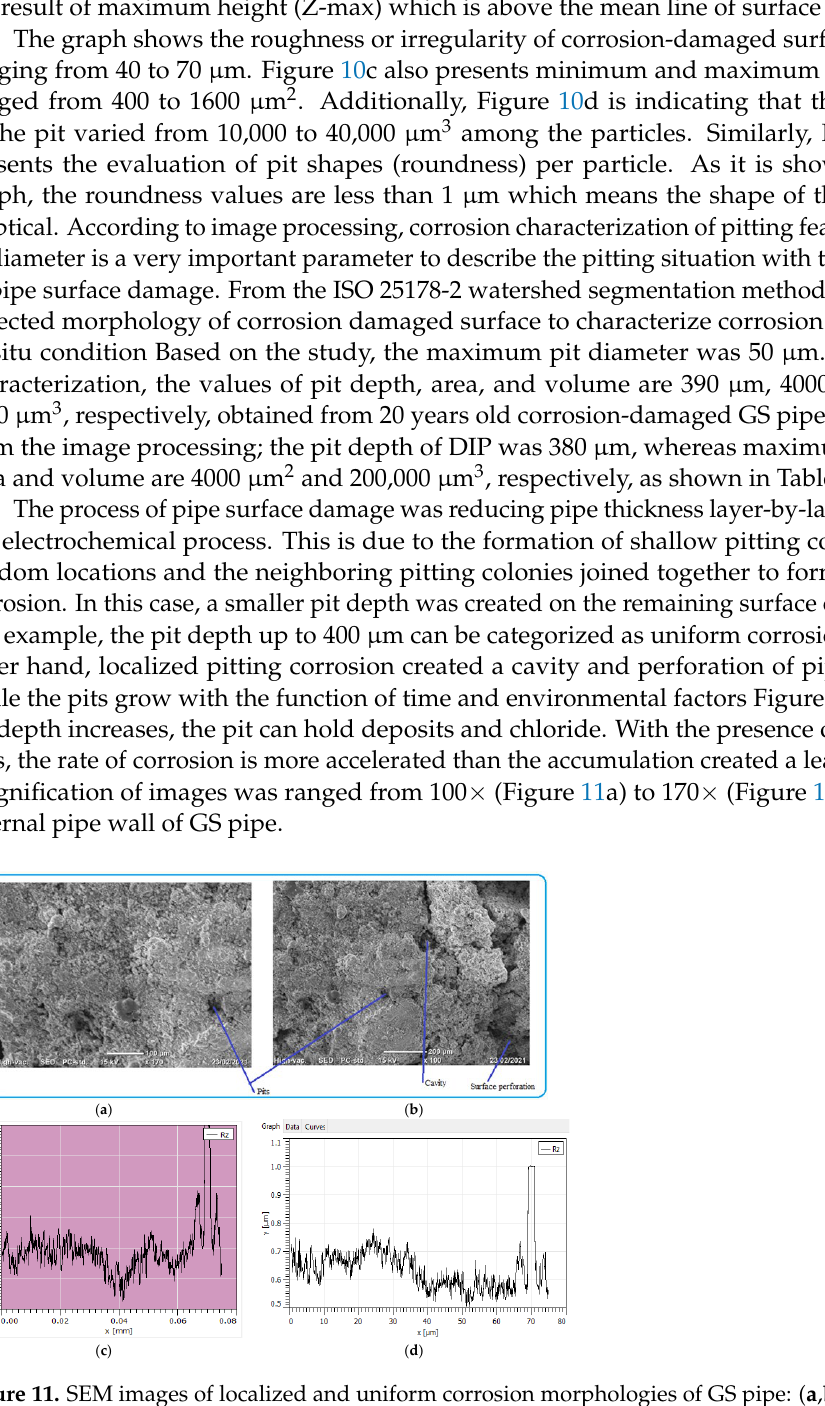
Table 4. A comparison of pitting features between GS and DIP pipes.